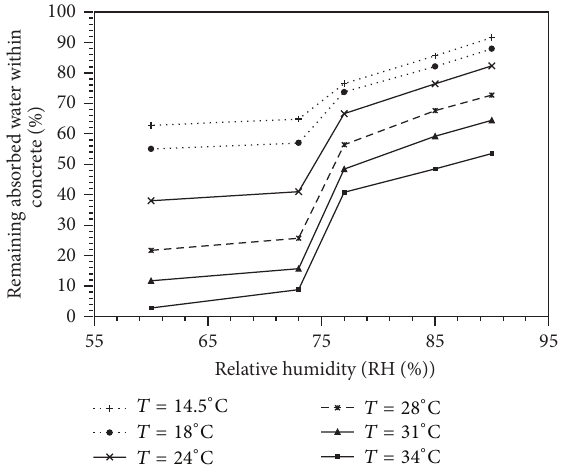
Figure 5: Desorption isotherm of SAP.